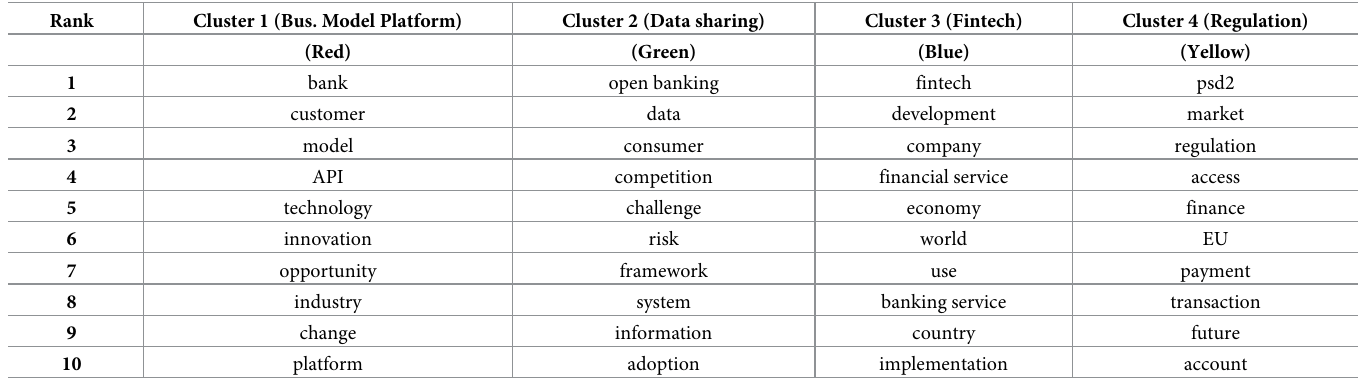
Table 1. Main components by